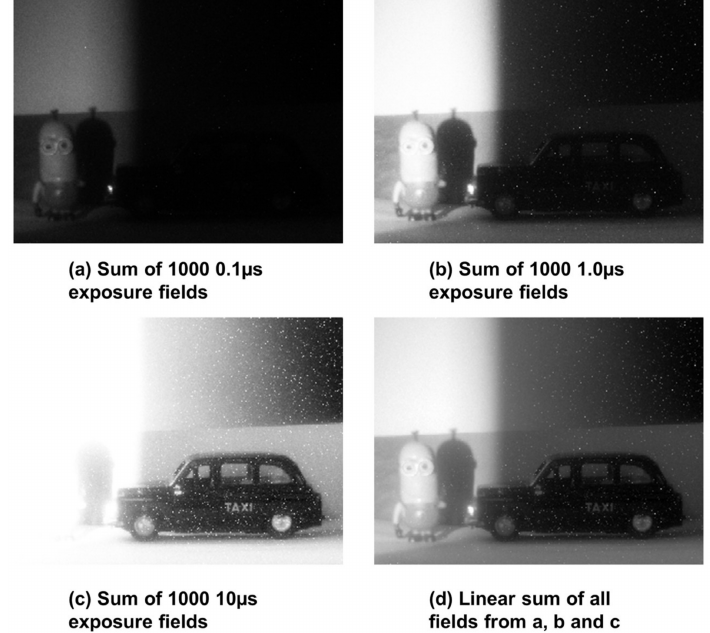
Figure 15. Images captured by 320 × 240 SPC sensor from [23]. ( a ) Sum of 1000 fields at 0.1 µ s exposure, a Minion appears in the lit portion of the scene; ( b ) Sum of 1000 fields at 1.0 µ s exposure, the Minion is slightly overexposed but a car figure appears in the dark region of the scene; ( c ) Sum of 1000 fields at 10 µ s exposure, Minion is completely overexposed but more detail of the car is apparent. Notice that high DCR pixels appear as white dots. ( d ) Linear sum of all the 3000 fields from a, b and c to form an HDR image preserving all